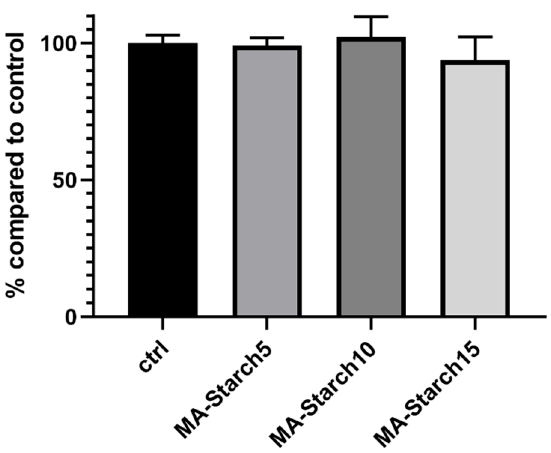
Figure 6. Cell viability of BJ cells culture using the supernatants collected from the starch-based hydrogels compared to the control conditions (black bars).